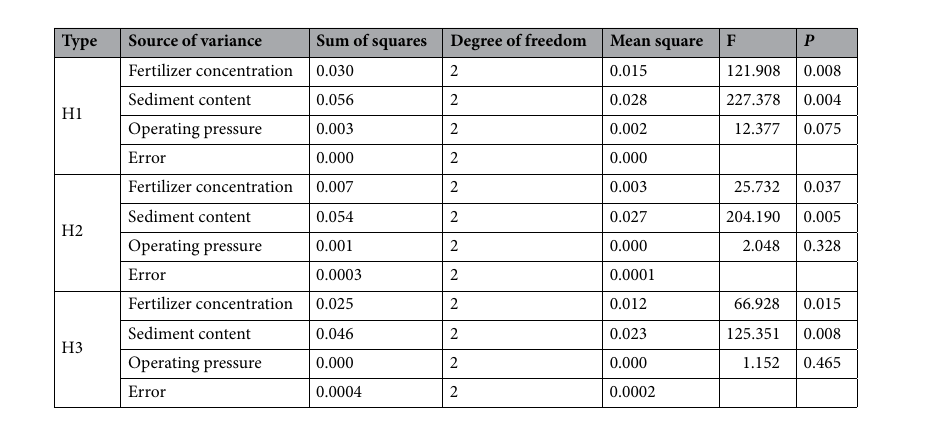
Table 4. Variance analysis of average relative flow. * P < 0.05, ** P <